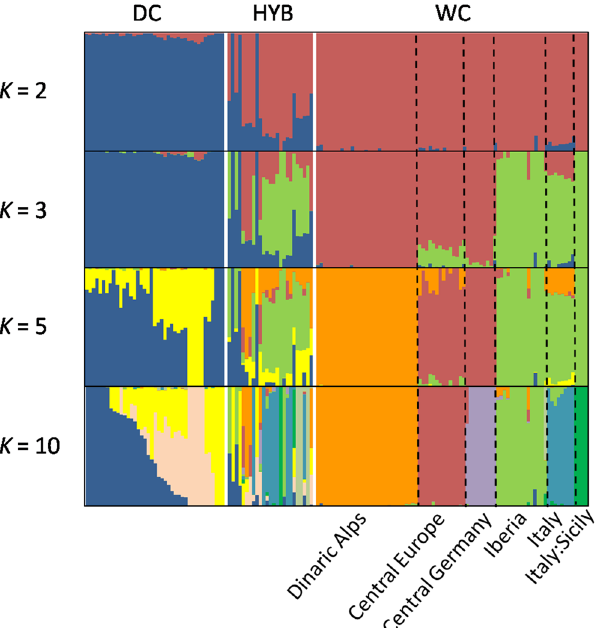
Figure 2. Admixture results from the 35k LD-pruned SNP panel set at K = 2, K = 3, K = 5 and K = 10. K = 2 clearly separates wild from domestic cats with admixed individuals showing intermediated assignment values. From K > 2 the genetic substructure of European wildcats progressively takes shape. At K = 3 the Northern European wildcat populations (including the Dinaric, the Central European and the Central Germany areas) split from the Southern ones (including the Italian and the Iberian Peninsulas). At K = 5 the Dinaric wildcat population groups apart from the Central European and the Southern ones and domestic cats form two distinct sub-clusters. At K = 10 the five biogeographic macro-populations already identified in Europe through STR analyses (Iberian, Italian, Central European, Dinaric and Central Germany populations 27 ) are confirmed, with an additional cluster including the Sicilian